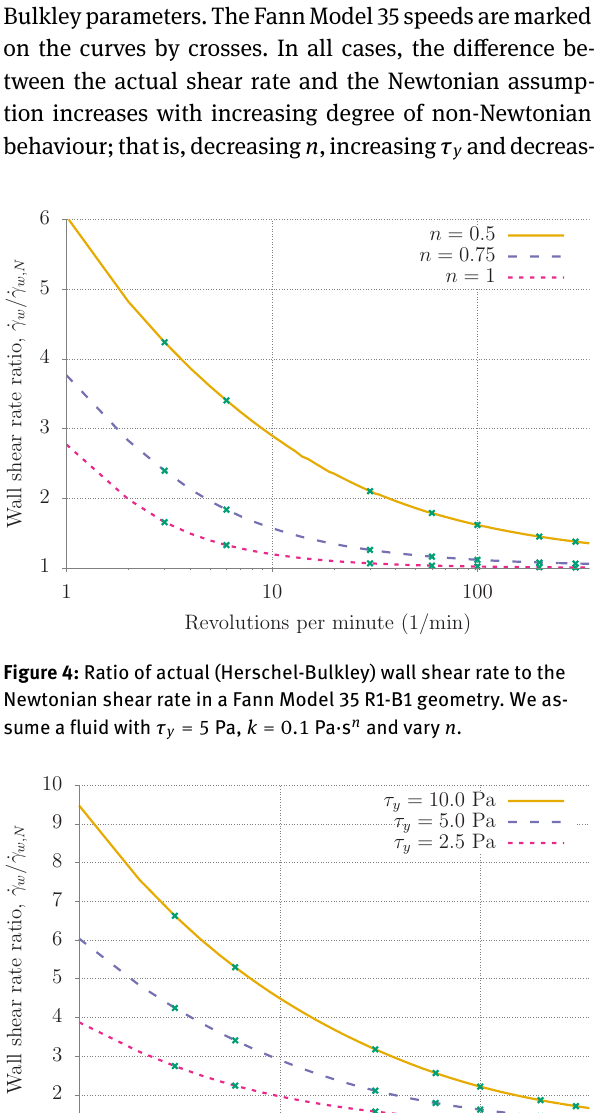
Figure 3: Normalized angular velocity of the Herschel-Bulkley fluid τ = (5.0 + 0.1˙ 𝛾 0.5 ) Pa in a Fann Model 35 R1-B1 geometry evaluated at different rotational velocities of the outer cup. The viscosity- independent Newtonian result is also plotted, for comparison.